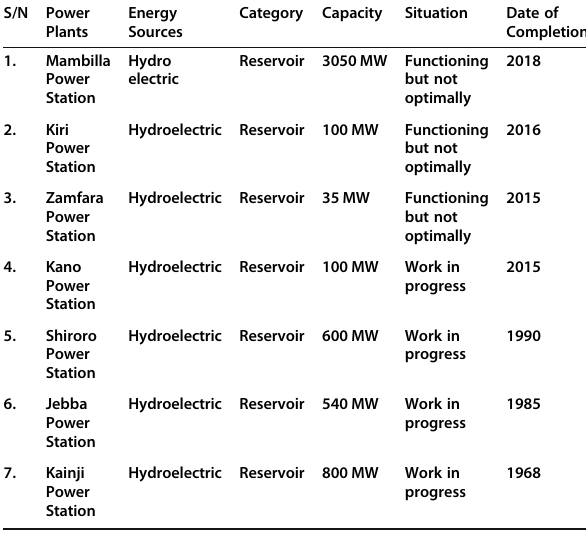
Table 1 Power Plants in Nigeria Using Renewable Energy Sources but not at Maximum